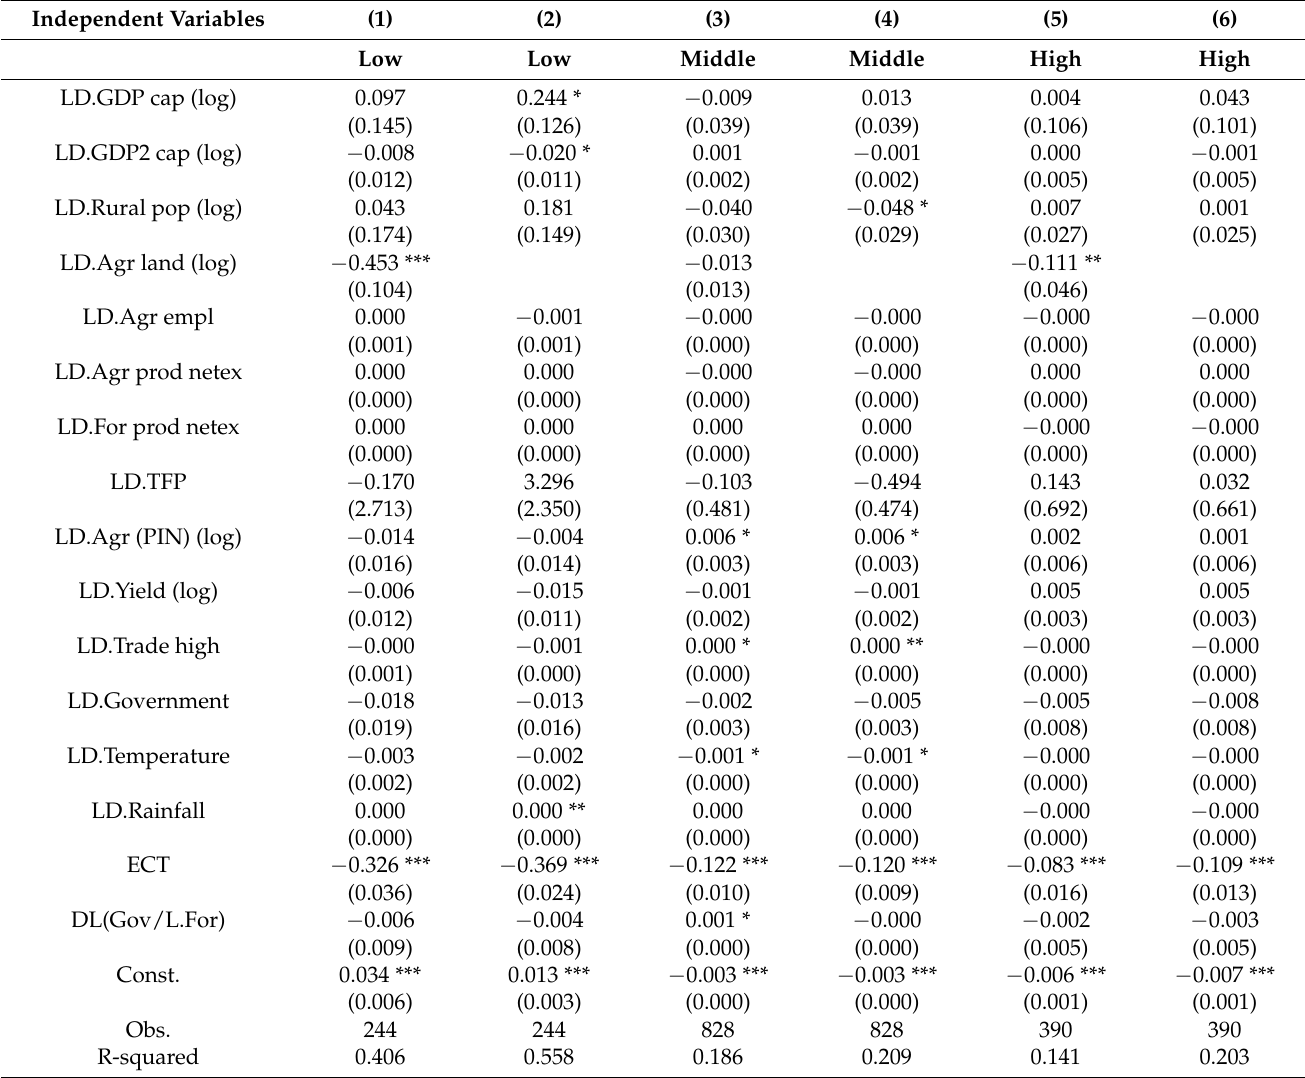
Table 5. Short-run equations, income